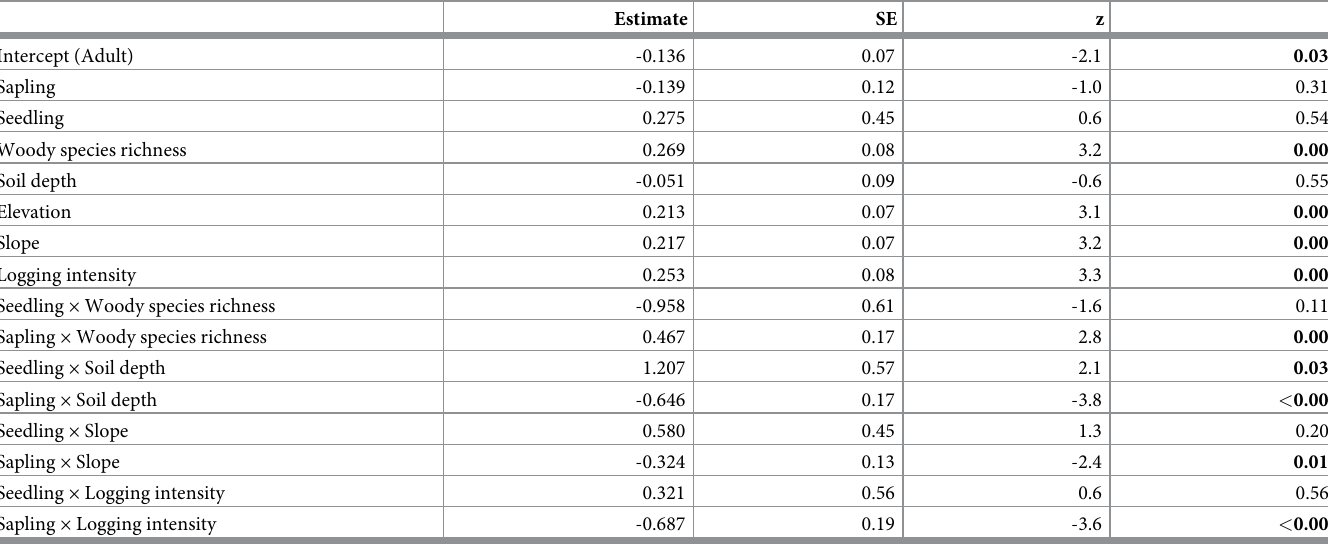
Table 2. Results of a logistic regression model, estimating how the probability of finding O . europaea depends on ontogenetic stage (adults [reference level], sapling, seedling) and environmental conditions and human disturbance (logging intensity) in Hugumburda dry Afromontane forest in northern Ethiopia.